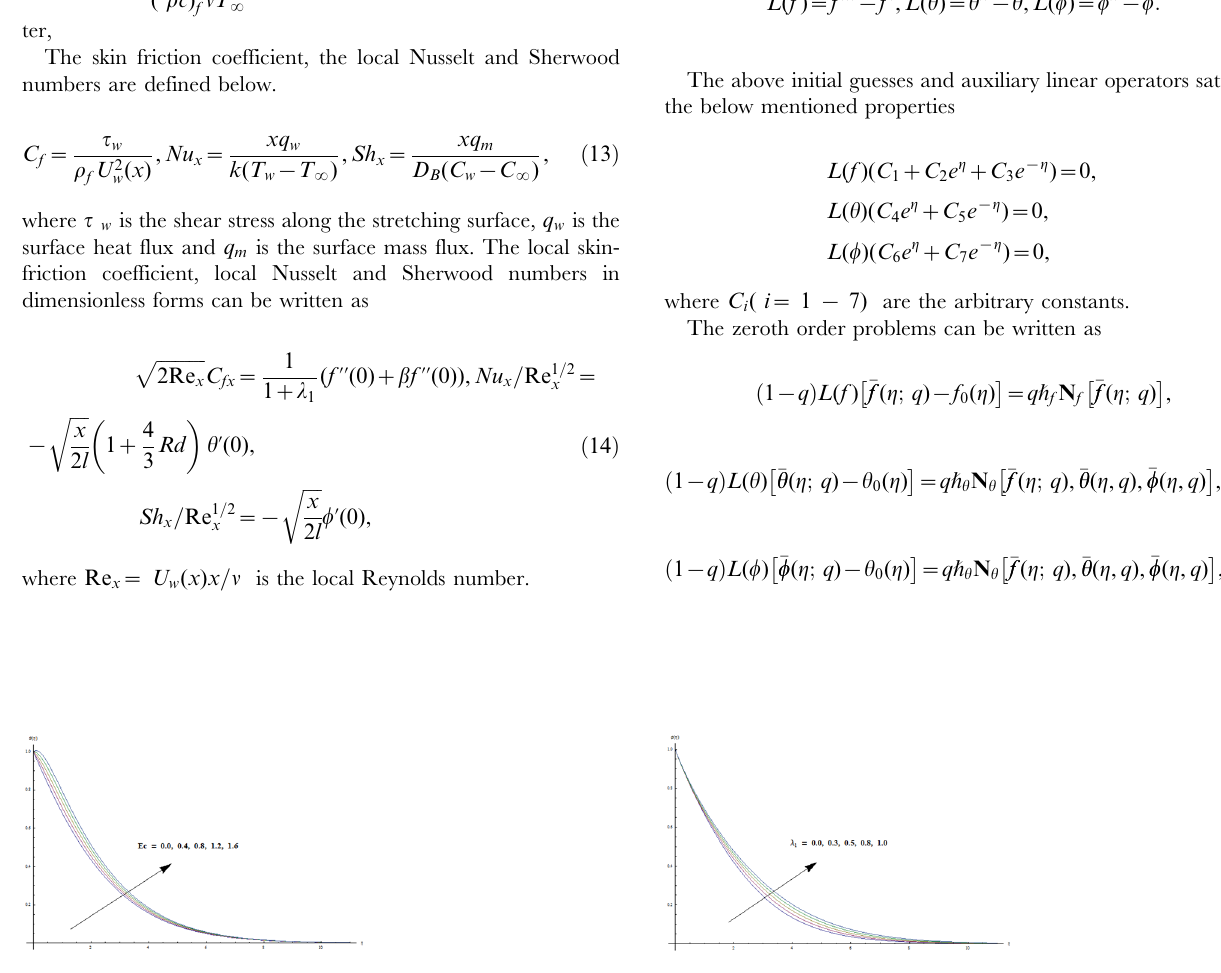
Figure 7. Variation in dimensionless temperature h ( g ) vs g for different values of Ec when l 1 ~ 0 : 3, b ~ 0 : 2, M ~ 0 : 5,